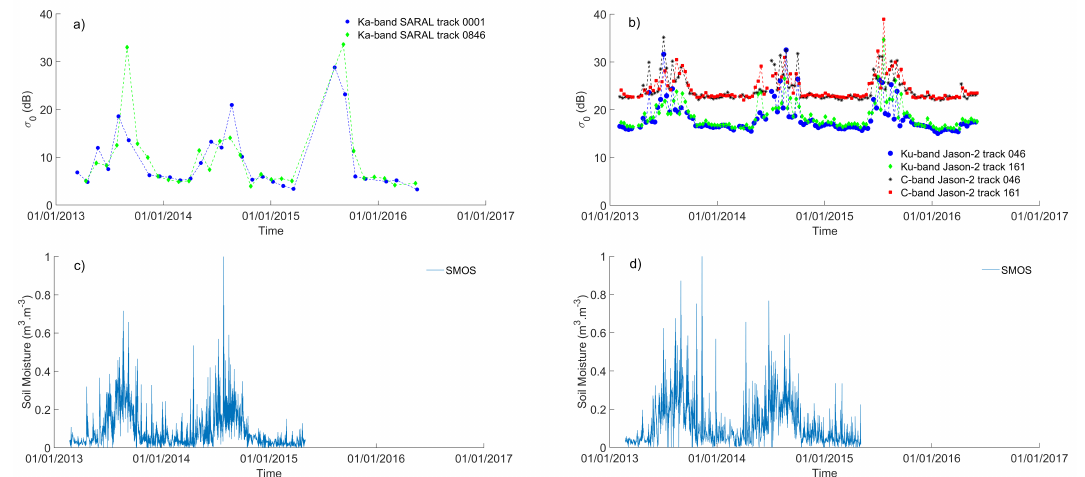
Figure 22. Time-series of backscattering coefficient (dB) for ( a ) SARAL/AltiKa (Ka-band) 0001 (blue) and 0846 (green) tracks and ( b ) Jason-2 (Ku and C-bands) 046 (blue and black) and 161 (light green and red), of volumetric soil moisture (m3.m-3), from SMOS (blue) at SARAL/AltiKa ( c ) and Jason-2 ( d )